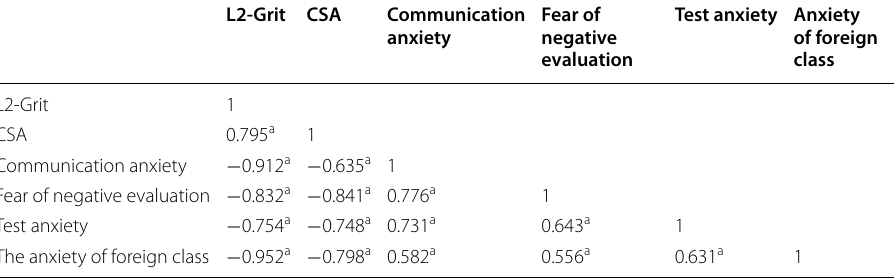
a Correlation is significant at the 0.01 level